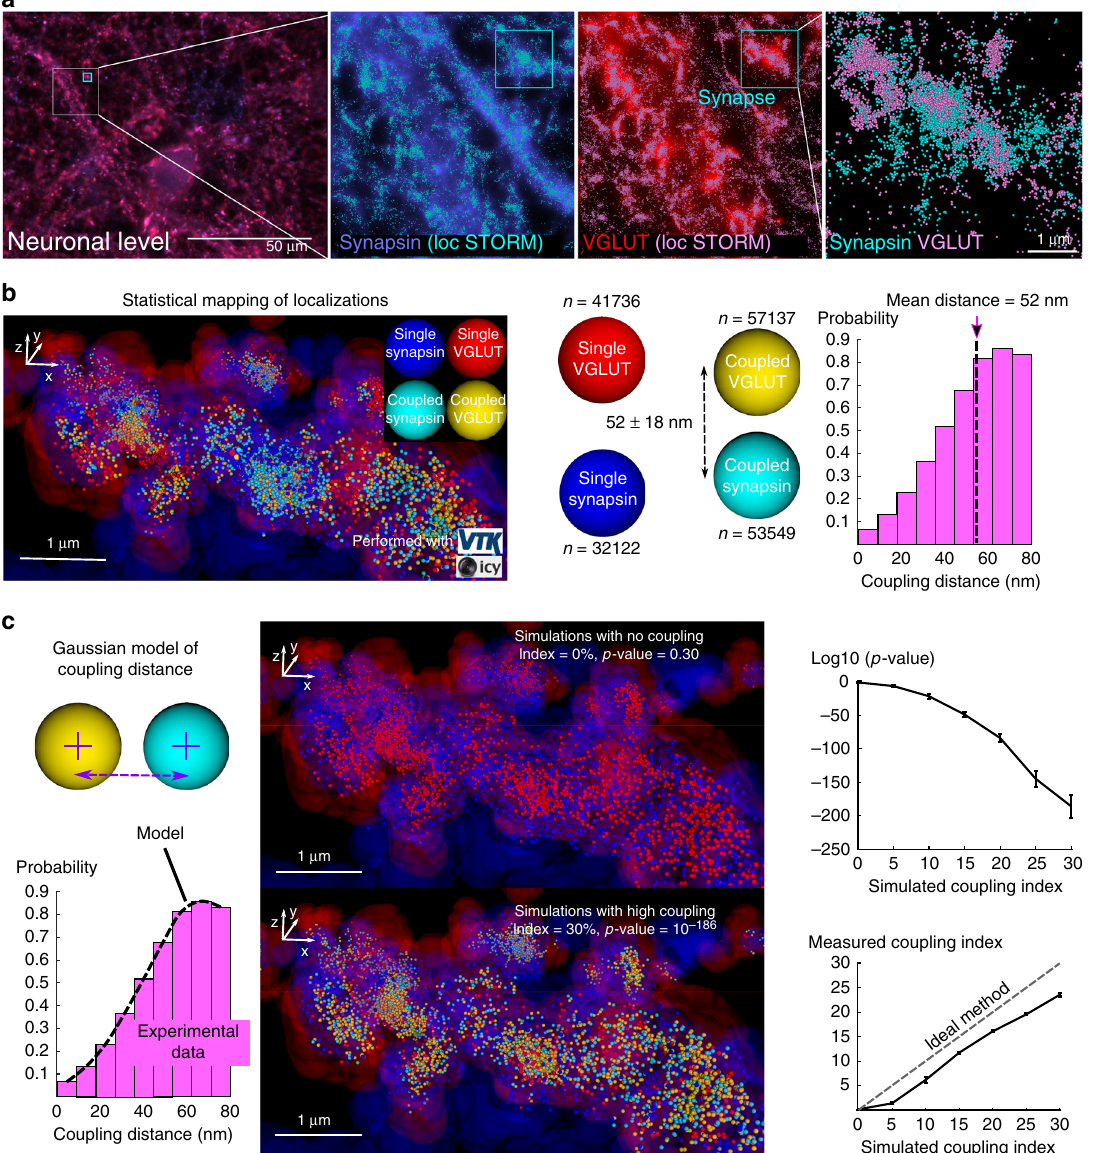
Fig. 5 Combining SODA and 3D-STORM imaging to map the coupling between VGLUT and Synapsin localisations inside presynaptic boutons. a VGLUT and Synapsin are imaged in cultured hippocampal neurons of mice with 3D-STORM. Field of view is a 20 microns square, with 2 microns depth. STORM localisations of Synapsin (cyan) and VGLUT (magenta) are super-imposed to wide- fi eld channels on Bruker Vutara Srx software (see also Supplementary Movie 1). High densities of molecules ’ localisations correlate with bright areas in wide fi eld microscopy. Inside synapses, the 3D localisations of Synapsin and VGLUT are densely packed together. b Using DBSCAN method (Material and Methods), volumes with densely packed VGLUT (red enveloppe) and Synapsin (blue enveloppe) are automatically delineated. The intersection between VGLUT and Synapsin volumes corresponds to putative synaptic boutons. Inside putative boutons, single (VGLUT: red localisations, Synapsin: blue localisations) and coupled (VGLUT: yellow localisations, Synapsin: cyan localisations) are statistically mapped with SODA. 3D VTK rendering in Icy is used to visualise localisations (coloured spheres). Histogram of computed coupling distances with SODA is shown (mean = 52 nm, n ≈ 250,000 individual couples, s.e.m = 0.04 nm). c The coupling distance is modelled with a (thresholded) Gaussian process with mean = 68 nm, s.d. = 28 nm and upper-bound = 80 nm (Material and Methods). Synapsin localisations are simulated around experimental VGLUT localisations inside the extracted putative boutons (ROIs), for increasing coupling index (0% (no coupling) to 30% (high coupling)). For each simulated coupling index, coupling parameters are estimated with SODA, and the single and coupled localisations are statistically mapped (error bars = ± s.e.m, N = 8 simulations per coupling index (i.e. 2 simulations per n = 4 STORM images)). Black dashed line corresponds to the ideal method that would estimate a coupling index equal to the simulated ground